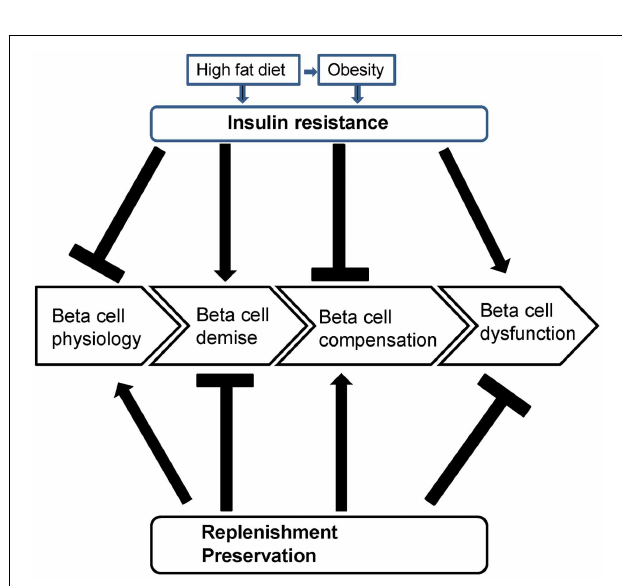
FIGURE 3 | Beta cell dysfunction and insulin resistance